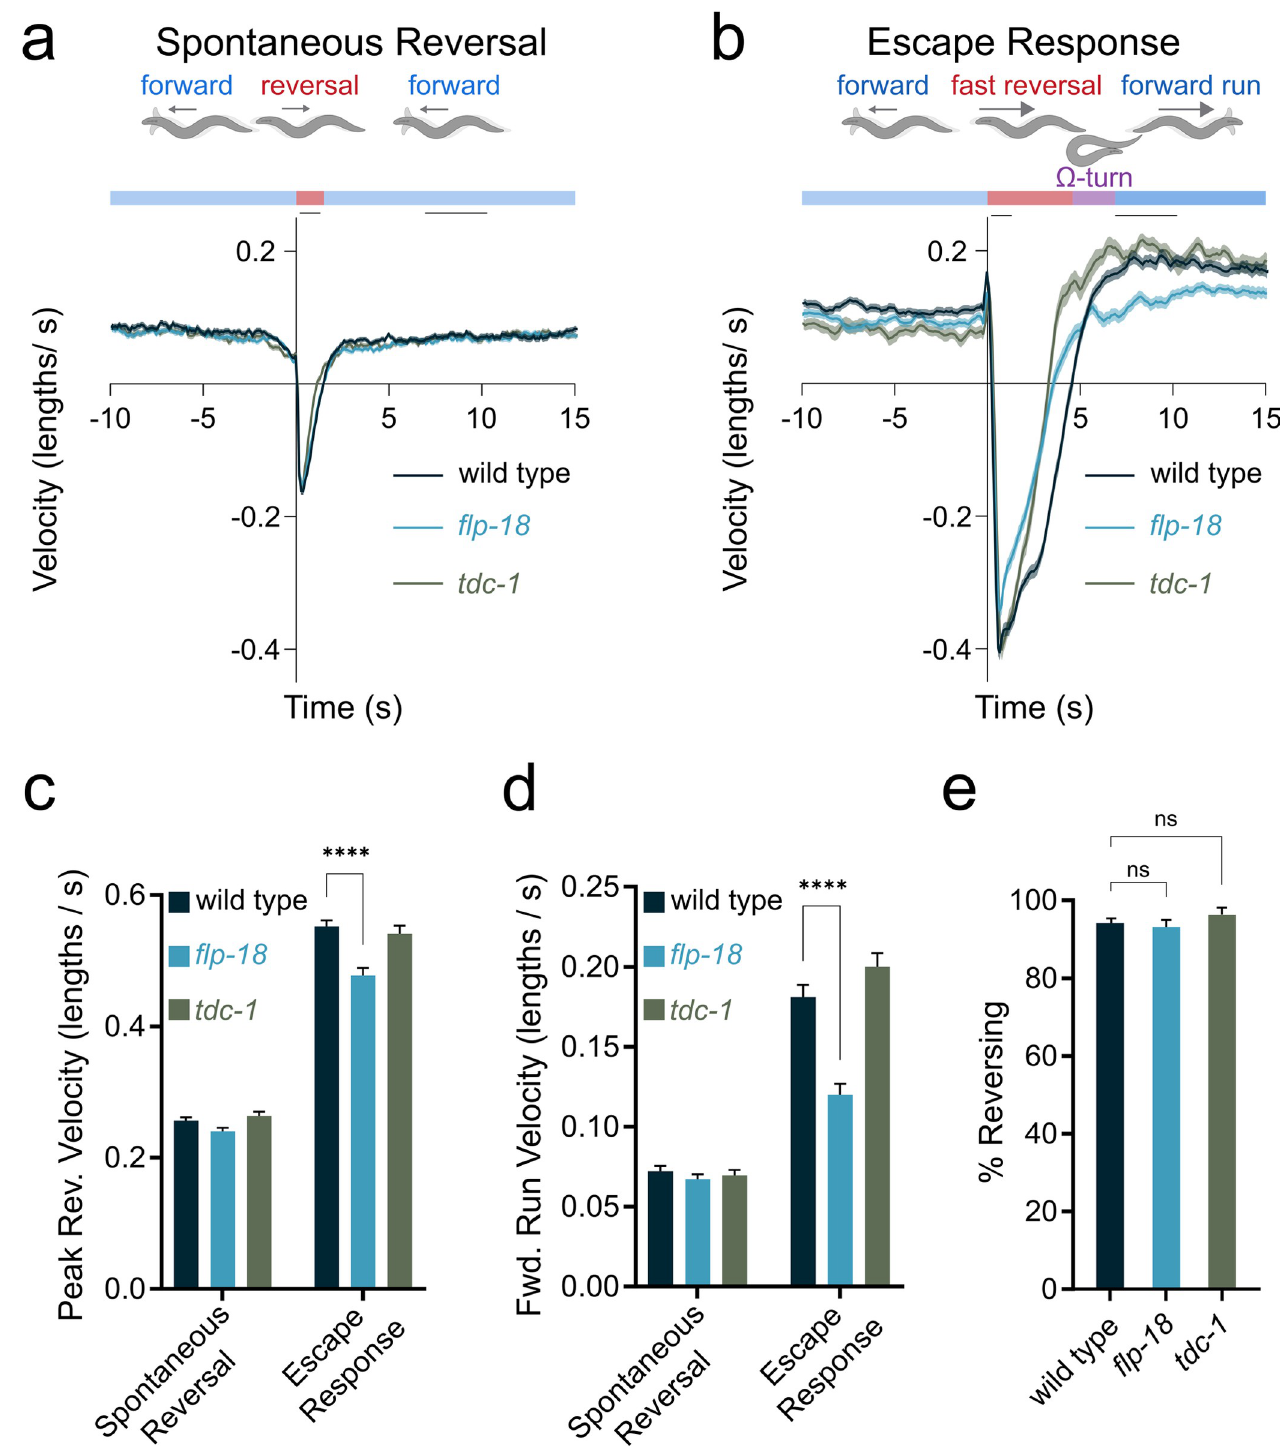
Fig 1. Increase in locomotion speed following a mechanical stimulus. Backward- and forward-velocity upon a spontaneous or tap-induced reversal. Wild- type animals show a persistent increase in locomotion speed in response to a strong tap stimulus (“forward run”). flp-18 mutants do not show a robust increase locomotion speed in response to a strong tap stimulus. (A-B) Schematic illustrating behavioral sequence (top) and velocity traces (bottom) from wild type animals, flp-18 , and tdc-1 mutants, aligned to reversal events. Negative velocity indicates backward locomotion. Dark lines represent mean velocity and shaded region represents standard error. Black lines at the top of the graph indicate the time periods when reversal and forward run speed were quantified. Reversals